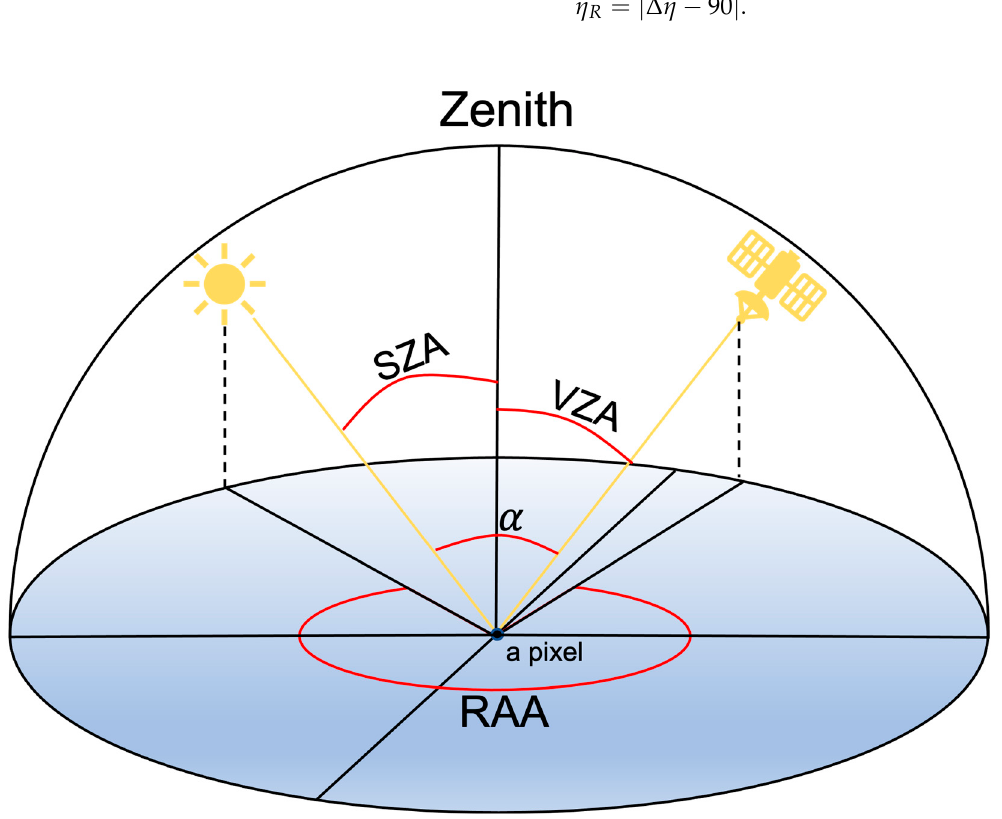
Figure 2. Schematic Diagram of the GOES-17 sun-view